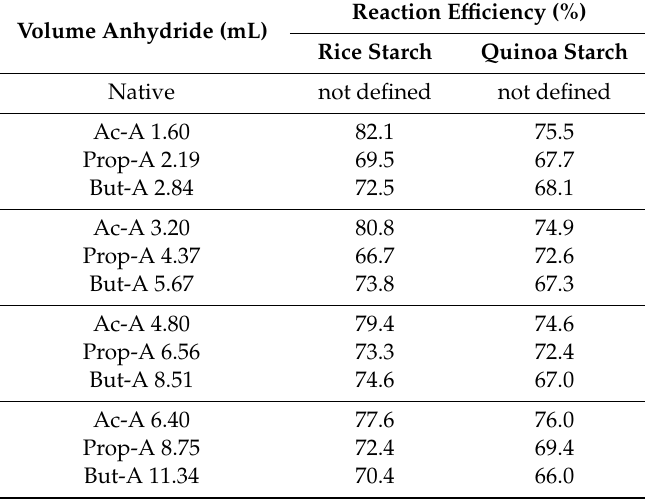
Table 4. Reaction e ffi ciency of acetylated, propionylated, and butyrylated rice and quinoa starch based on